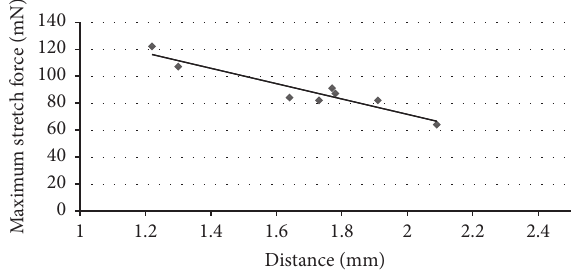
Figure 6: The correlation between eccentric distance and maximum stretch force in the eccentric CCC subgroup. There was a significant negative correlation between eccentric distance and maximum stretch force ( 𝑟 = −0.7785 , 𝑝 = 0.0279